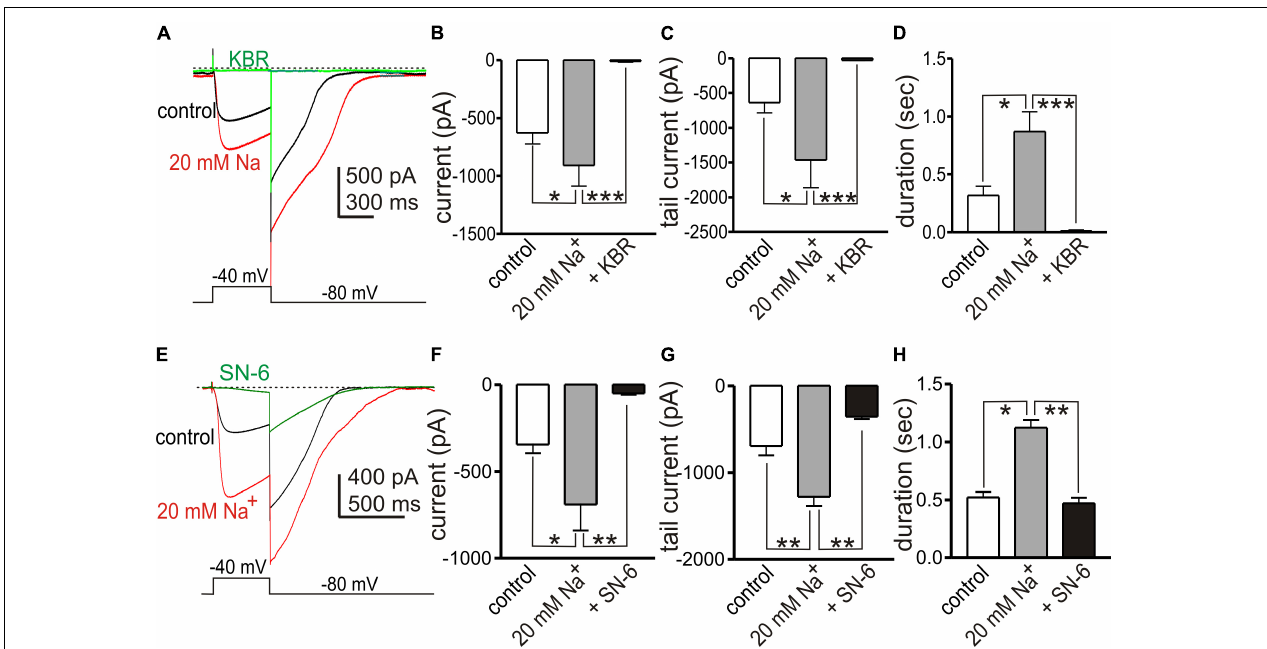
FIGURE 6 | Effects of shifting E NCX to more negative potentials on slow wave currents in small intestinal ICC. (A,E) Representative traces showing slow wave currents in small intestinal ICC evoked by step depolarizations (500 ms) from –80 to –40 mV. Repolarization to holding potential (–80 mV) resulted in long lasting tail currents that exceeded the deactivation properties of ANO1 (45). The sustained tail currents demonstrate the autonomous nature of the slow wave currents (i.e., once activated these responses persist even after repolarization). Reduced [Na + ] o (to 20 mM; 115 mM Na + replaced with equimolar Li + , Solution III) increased the amplitude of slow wave currents and the amplitude and duration of the tail currents (red traces), as compared to control currents (with 140 mM [Na + ] o , black traces). (A) KB-R7943 (5 µ M, KBR) and (E) SN-6 (5 µ M) reduced the slow wave currents and tail currents (green traces). (B–D) Summary data showing the effects of low [Na + ] o and KB-R7943 on the amplitude of slow wave currents (B) , the peak amplitude of tail currents (C) and the duration of tail currents (D) from 5 experiments. (F–H) Summary data showing the effects of low [Na + ] o and SN-6 on the amplitude of slow wave currents (F) , the peak amplitude of tail currents (G) , and the duration of tail currents (H) from four experiments. * p < 0.05, ** p < 0.01, *** p <